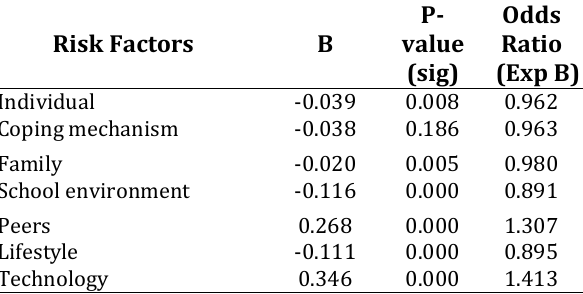
Table 4. Analysis Test Results of the Risk Factors on the Occurrence of Juvenile